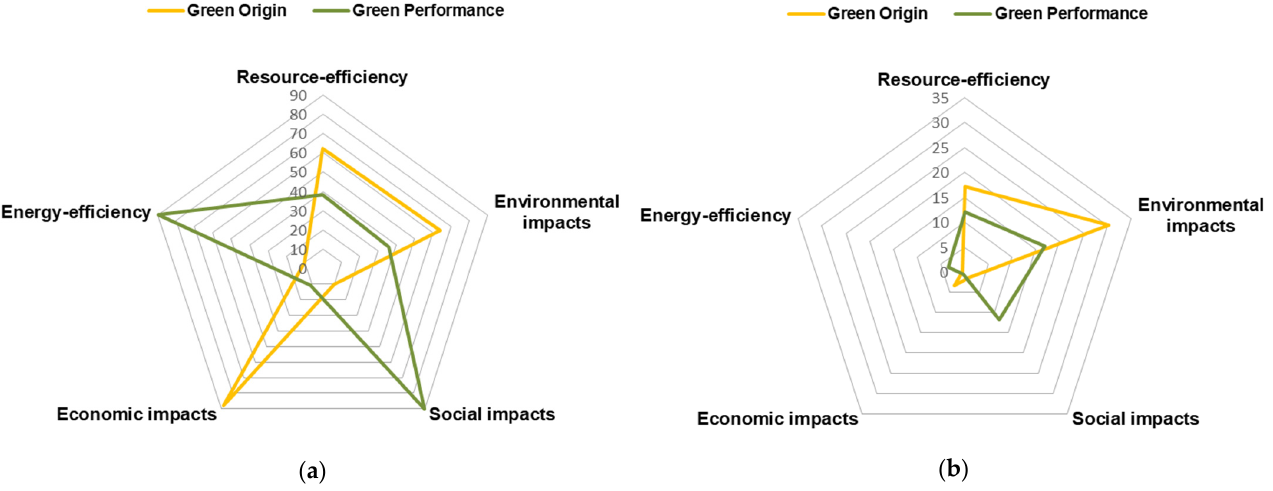
Figure 5. Sensitivity analysis concerning ( a ) local weights, ( b ) global weight.